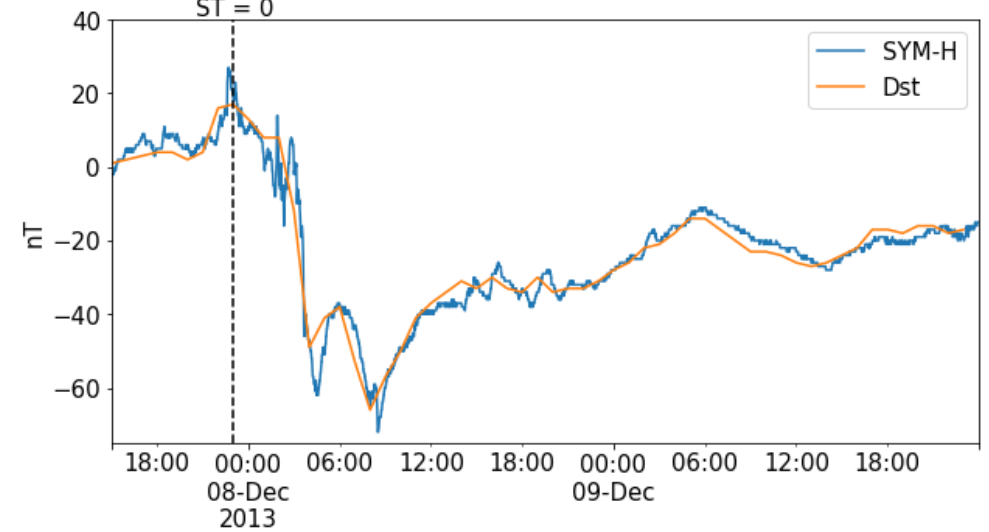
Figure 2. The geomagnetic storm time disturbance index Dst plotted together with the SYM-H index during a geomagnetic storm that occurred on 7–9 December 2013. The storm’s onset time (the time where maximum Dst is seen right before it starts decreasing), which corresponds to storm time = 0, is plotted as the dashed black